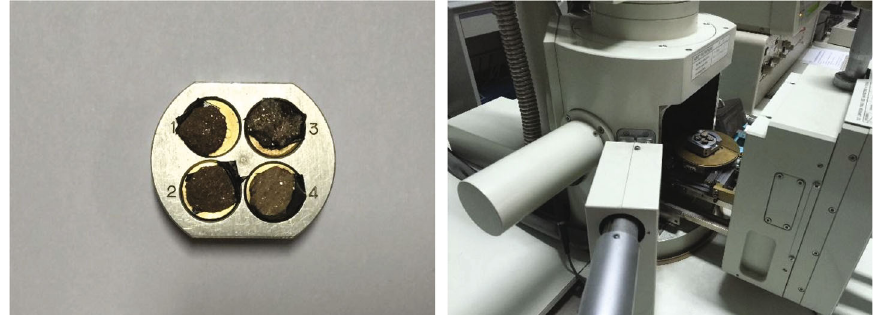
Figure 5: The specimen after gold